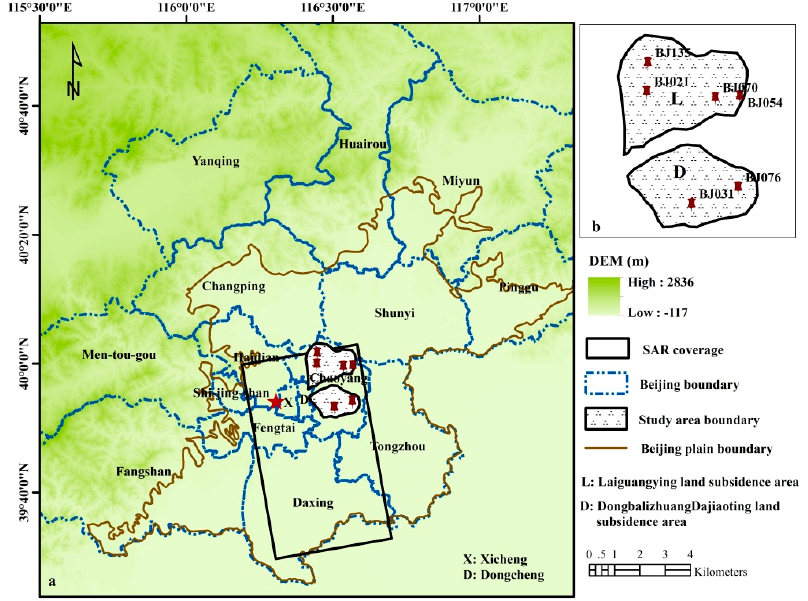
Figure 1. The geographic location of the study area. The red star is the location of reference points for interferometric synthetic aperture radar (InSAR) and leveling measurements. The red pushpins (BJ021, BJ031, BJ054, BJ070, BJ076, BJ135) in ( a ) and ( b ) indicate the locations of the leveling benchmarks. In ( a ), the black box represents the TerraSAR-X data spatial coverage. The quaternary aquifers of the Beijing plain have three aquifer groups [29,30]. The first aquifer